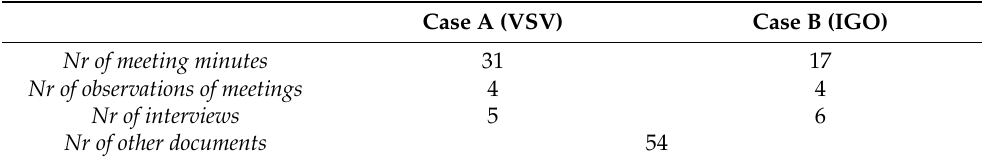
Table 1. Overview of Data